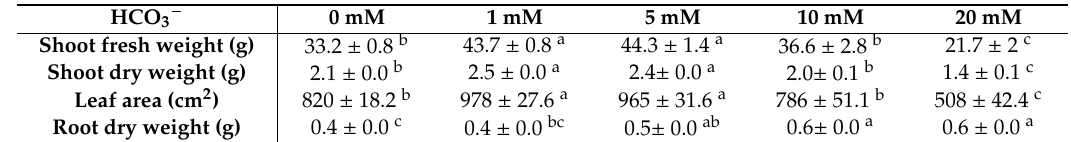
Table 1. Shoot fresh and dry weights, leaf area and growth rate of lettuce plants grown under 0, 1, 5, 10 and 20 mM HCO3-. Experiment 1. Values are means ± S.E. of 8 replicates, with di ff erent letters within a row denoting significant di ff erences between means (post-hoc LSD p < 0.05). HCO 3 −